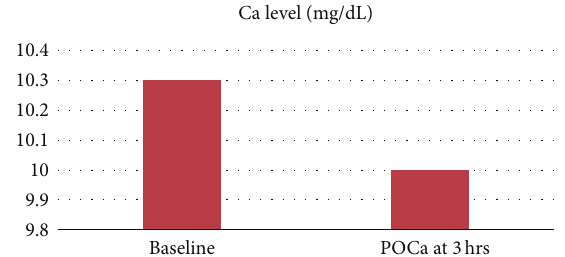
Figure 2: Perioperative calcium monitoring, POCa (postoperative calcium), and Mg/dL